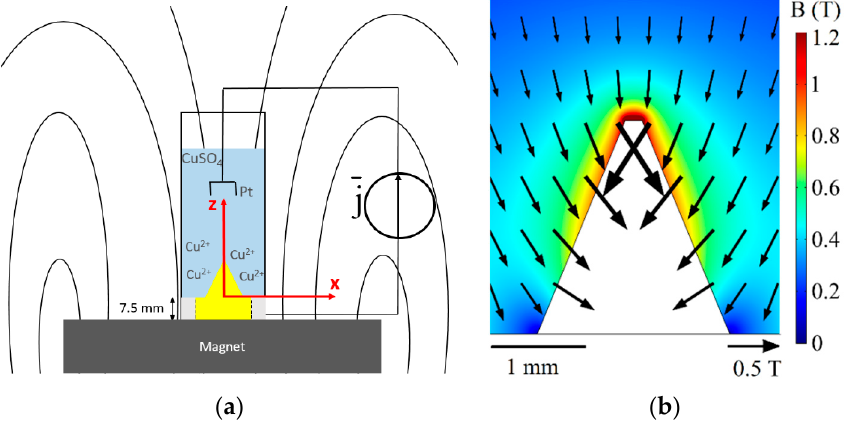
Figure 2. ( a ) Schematic view of the experimental setup, in which the cone is embedded in a quartz cuvette which is filled with copper (II) sulfate placed on a cylindrical NdFeB magnet (diameter = 20 mm, height = 20 mm, magnetization direction antiparallel to gravity). ( b ) Numerical results of magnitude and vector of the magnetic flux density generated by magnetizing the iron cone, which creates strong magnetic gradients near the cone tip.